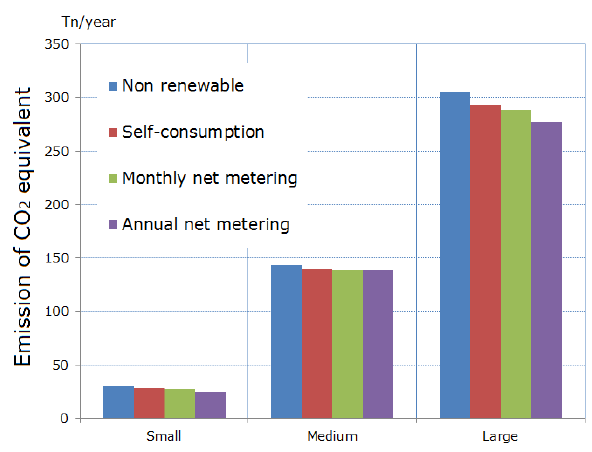
Figure 7. Comparison between emissions of equivalent CO 2 in olive mills powered with grid-connected PV and without renewable energies according to metering policy .